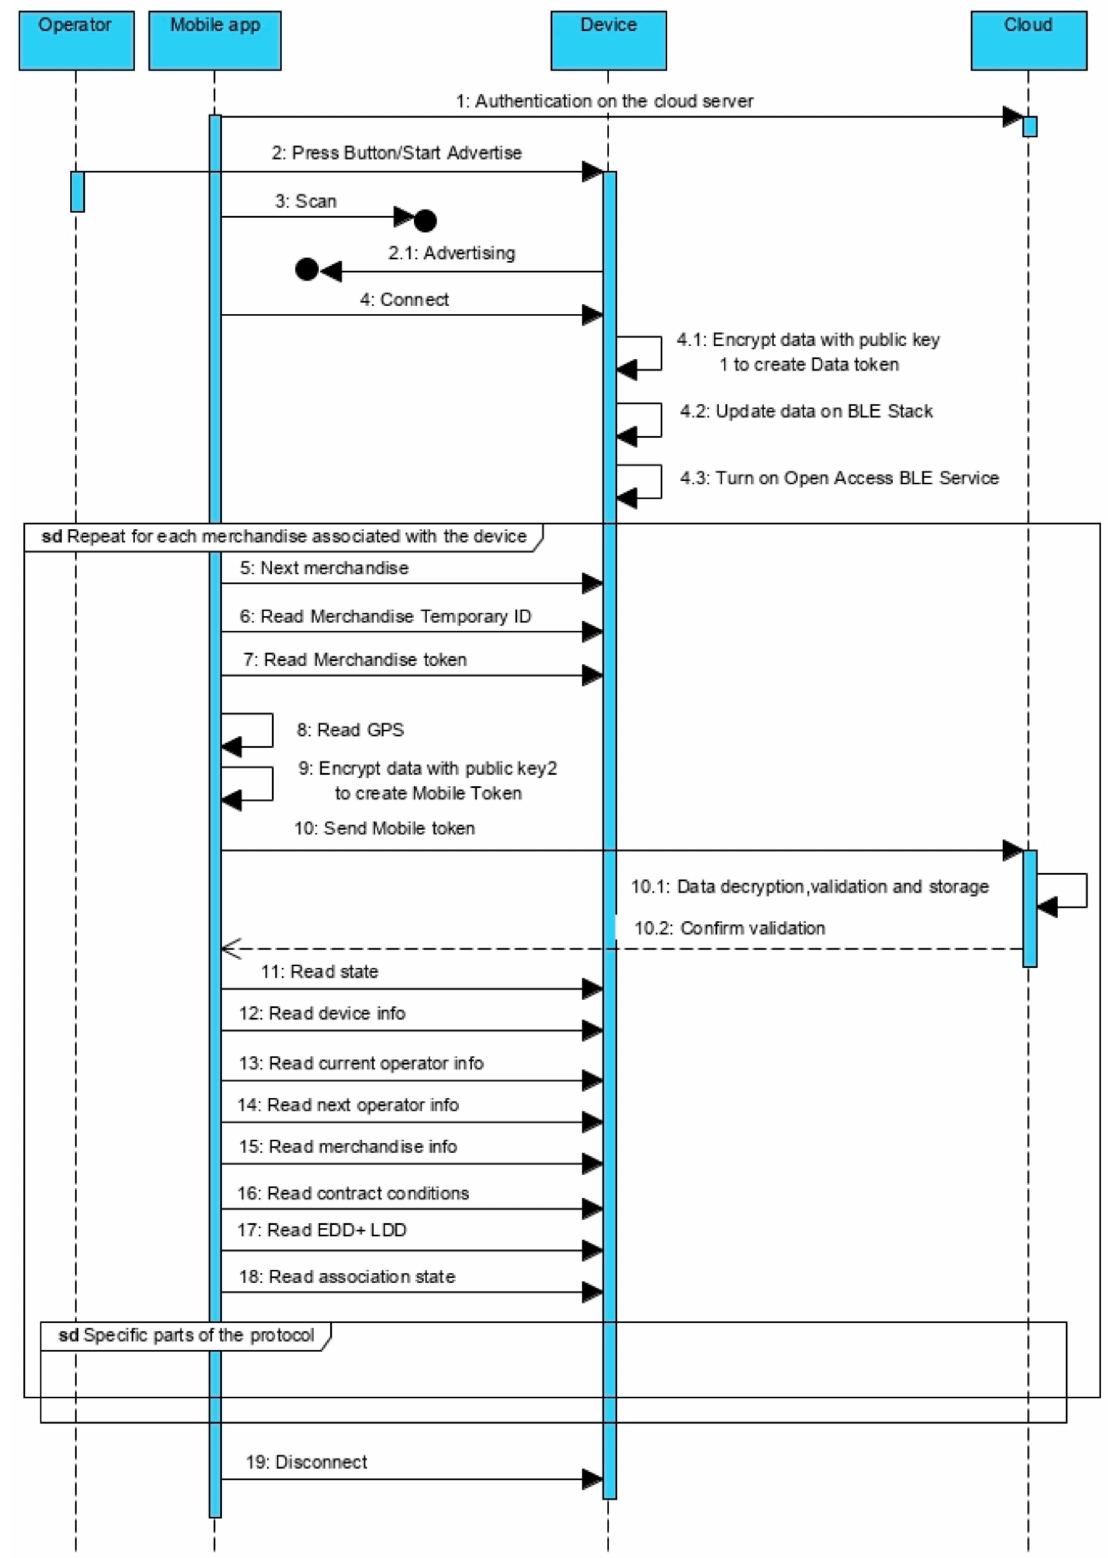
Figure 5. Iteration protocol between mobile app and